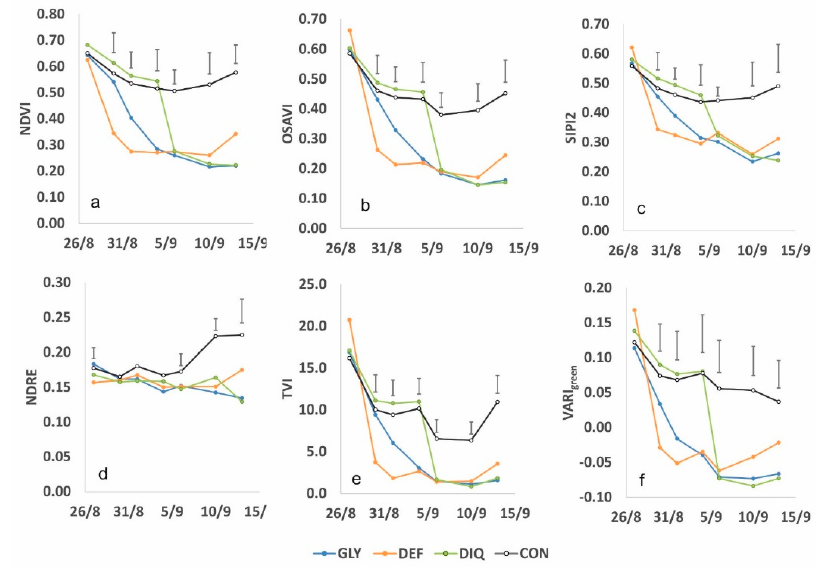
Figure 8. Changes in selected VIs after applying the harvest aids (GLY = Glyphosate 27/8, DEF = Spotlight ® 27/8, DIQ = Diquat 4/9 and CON = Control). Vertical bars denote LSD at p =